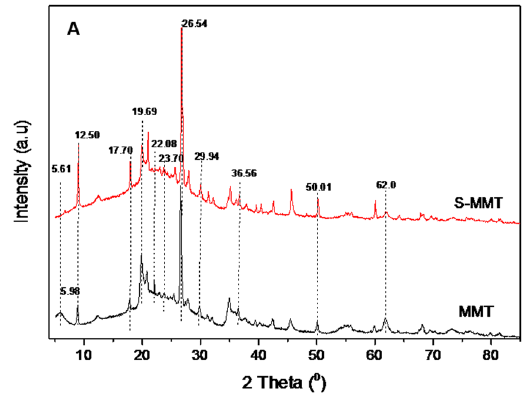
Figure 2. XRD patterns of MMT and S-MMT